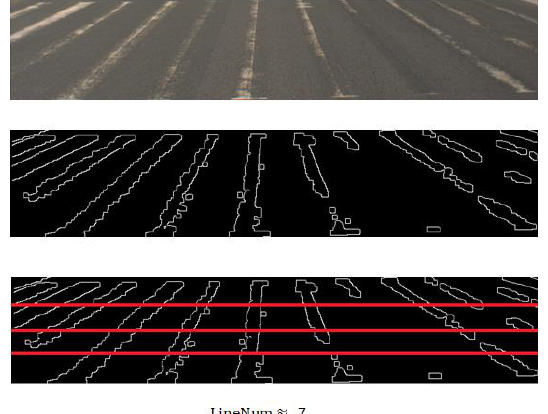
Figure 7. AOI map, contour map, crossing line map of a serious impaired crossing, with strip number calculated